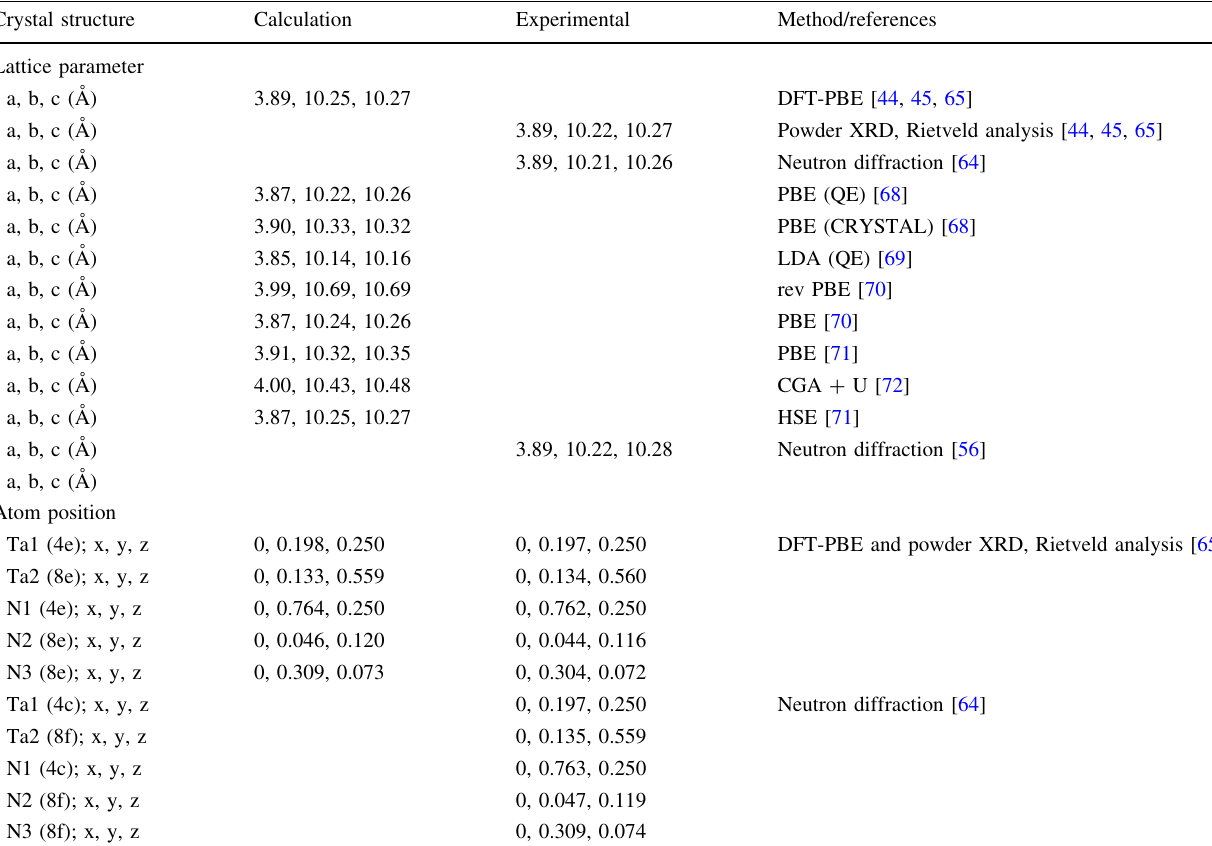
Table 1 Comparison of Ta 3 N 5 crystal structure obtained from theoretical calculation and experimental measurement Crystal